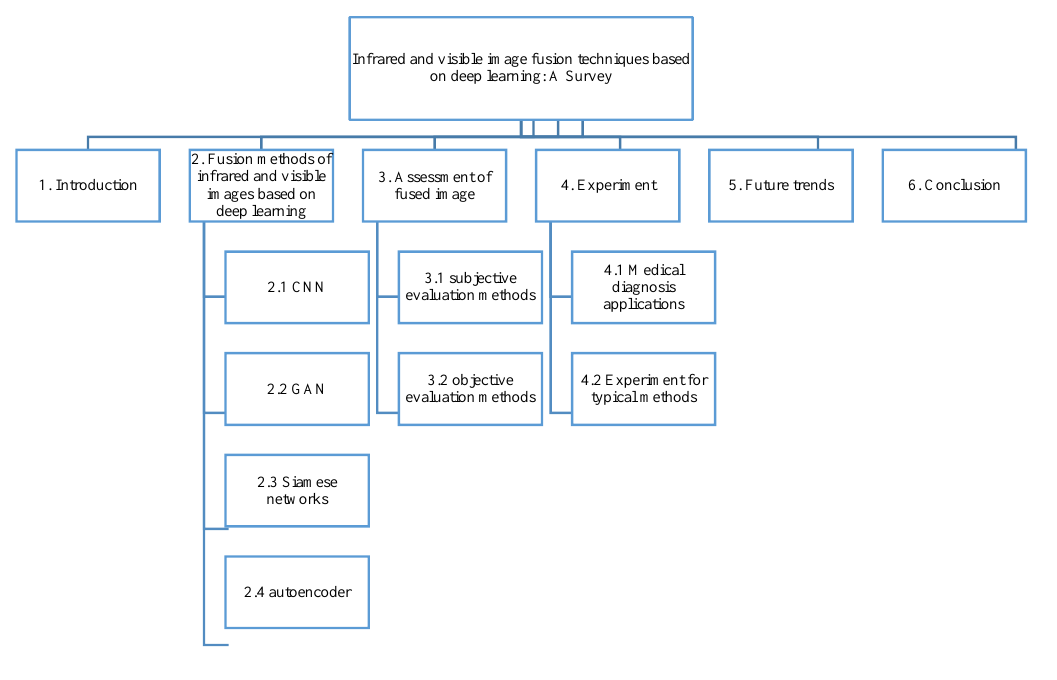
Figure 1. Structure of the survey.